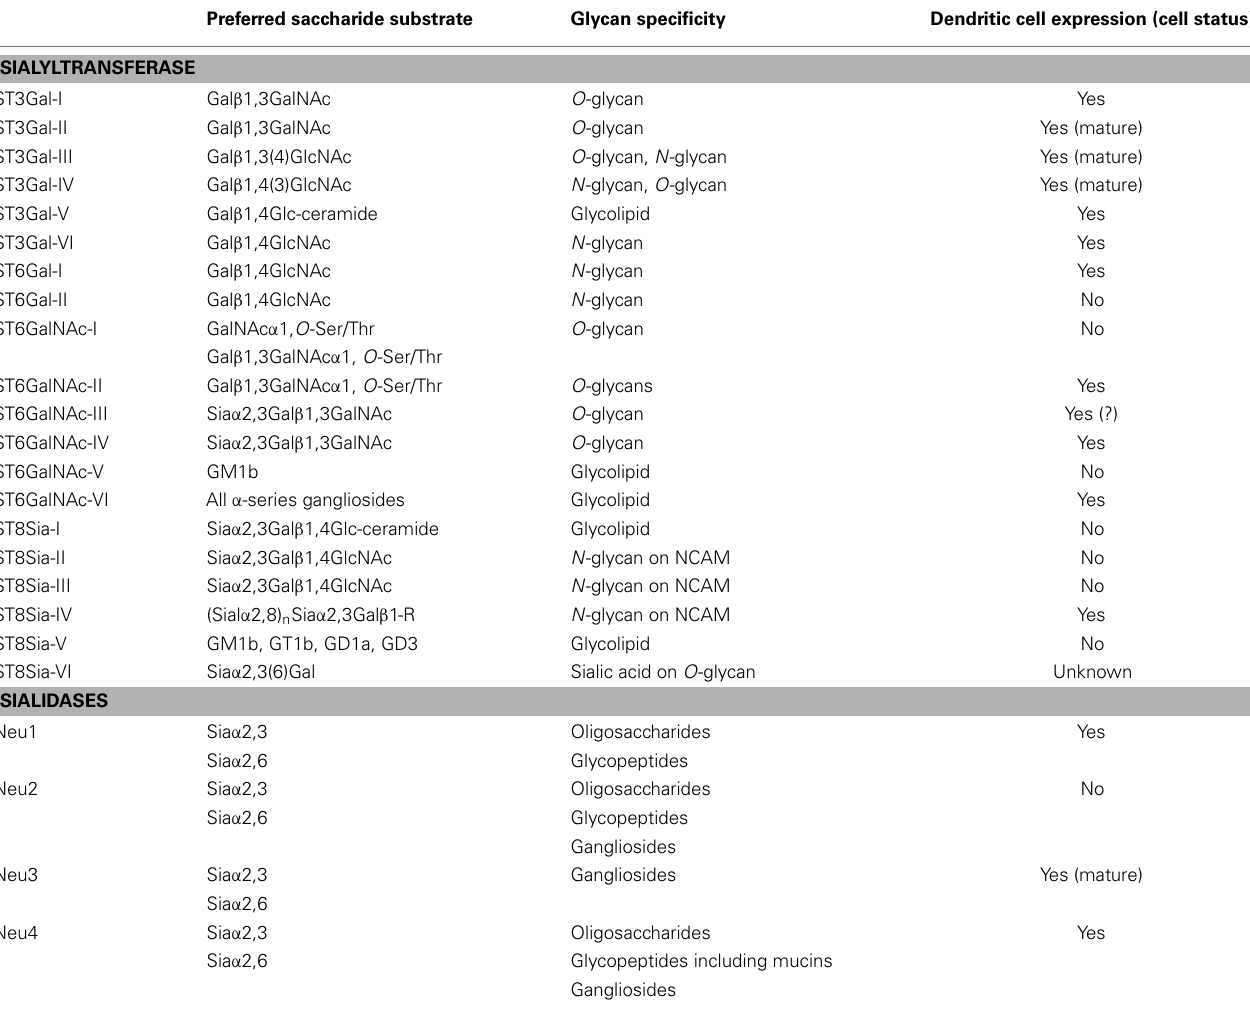
Table 1 | Human sialyltransferases and